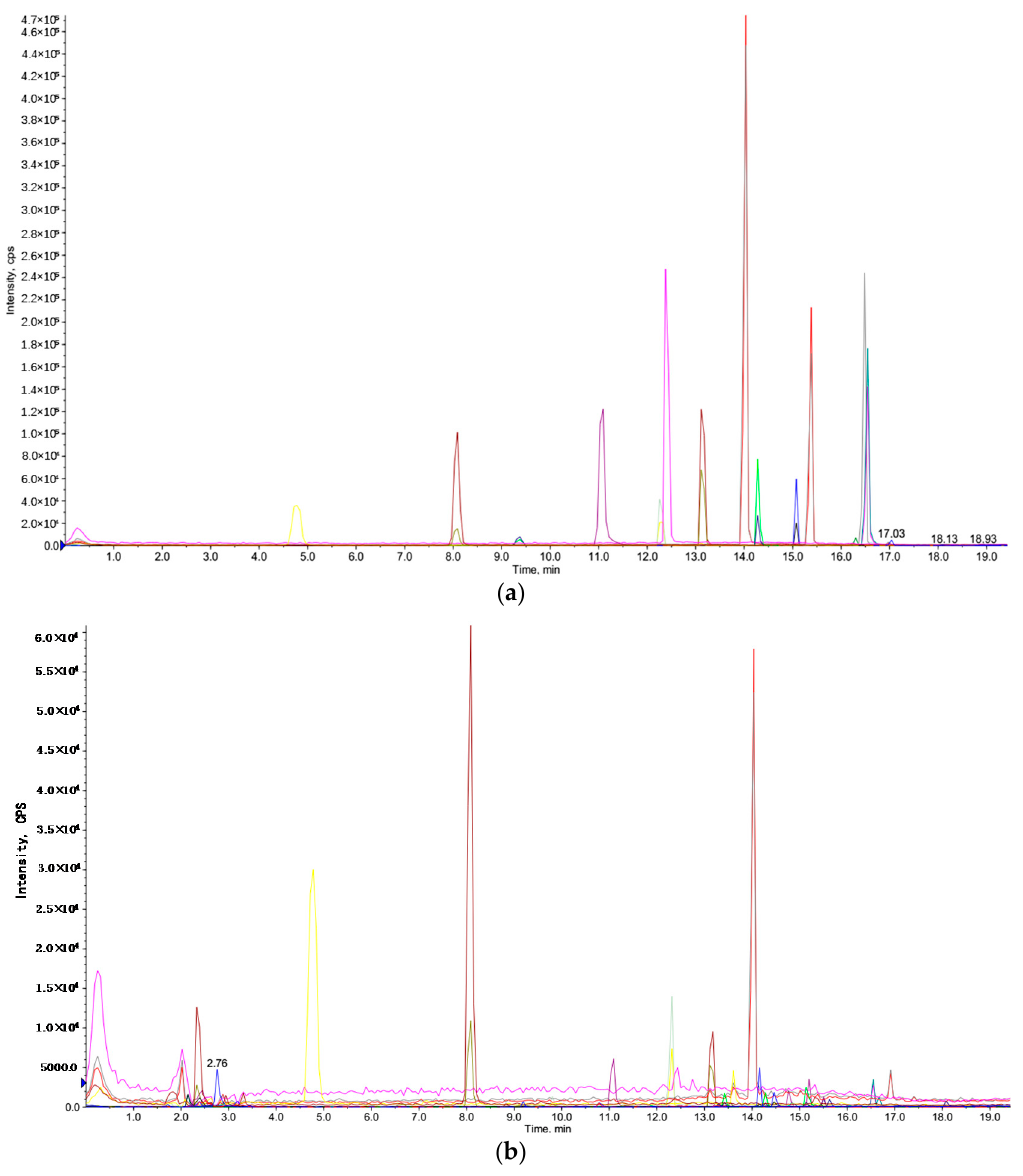
Figure 4. The total ion chromatograms of standard compounds ( a ) and the sample obtained under the optimal conditions ( b ). Table 4. The contents of phenolic components in extract obtained under the optimal condition.